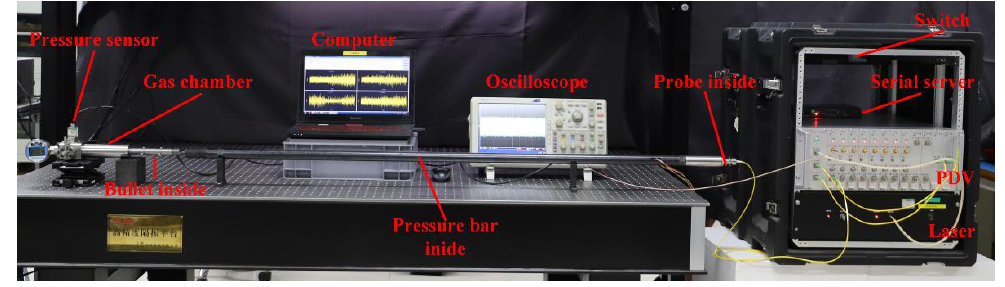
Figure 7. A photograph of the testing system.